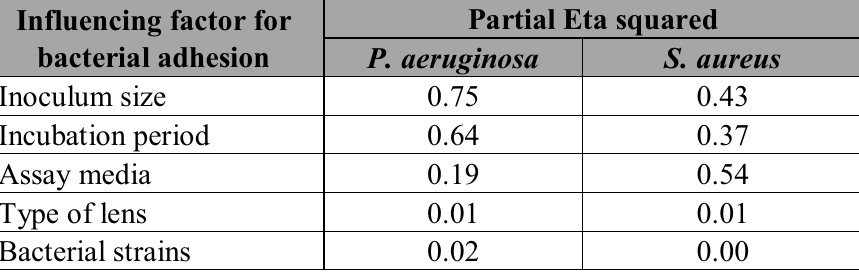
Table 3. Effect size of factors that influence bacterial